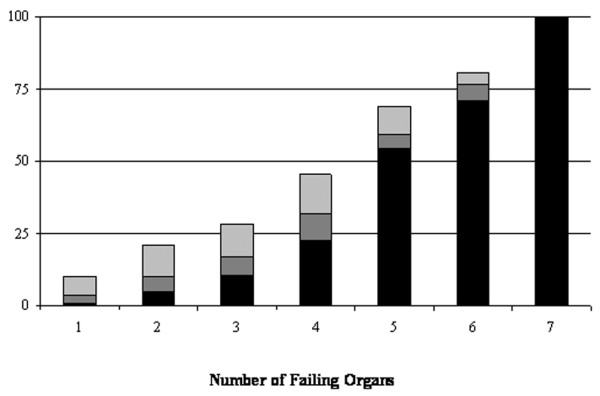
Mortality (percentage) of critically ill patients with different numbers of failing organs at intensive care unit discharge (black), hospital discharge (black + dark grey), and 1 year after intensive care unit admission (black + dark grey + light grey).